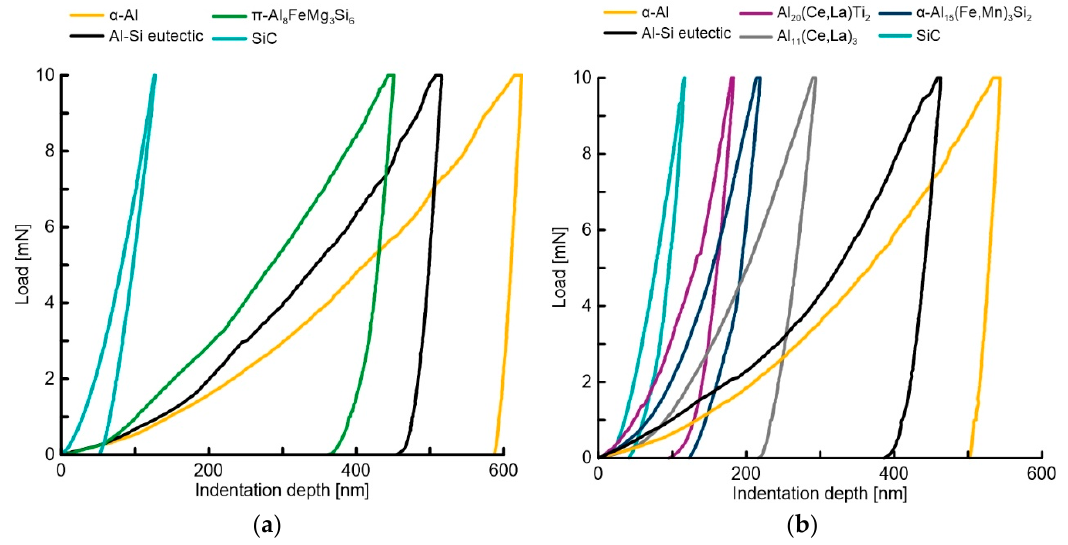
Figure 4. Plots of load vs. indentation depth for each phase: ( a ) Material C0; ( b ) Material C1.